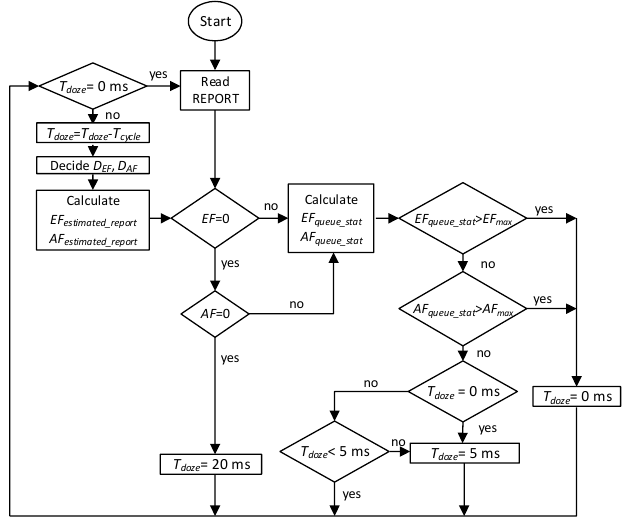
Figure 2. Calculation for the doze duration 𝑇 𝑑𝑜𝑧𝑒 .